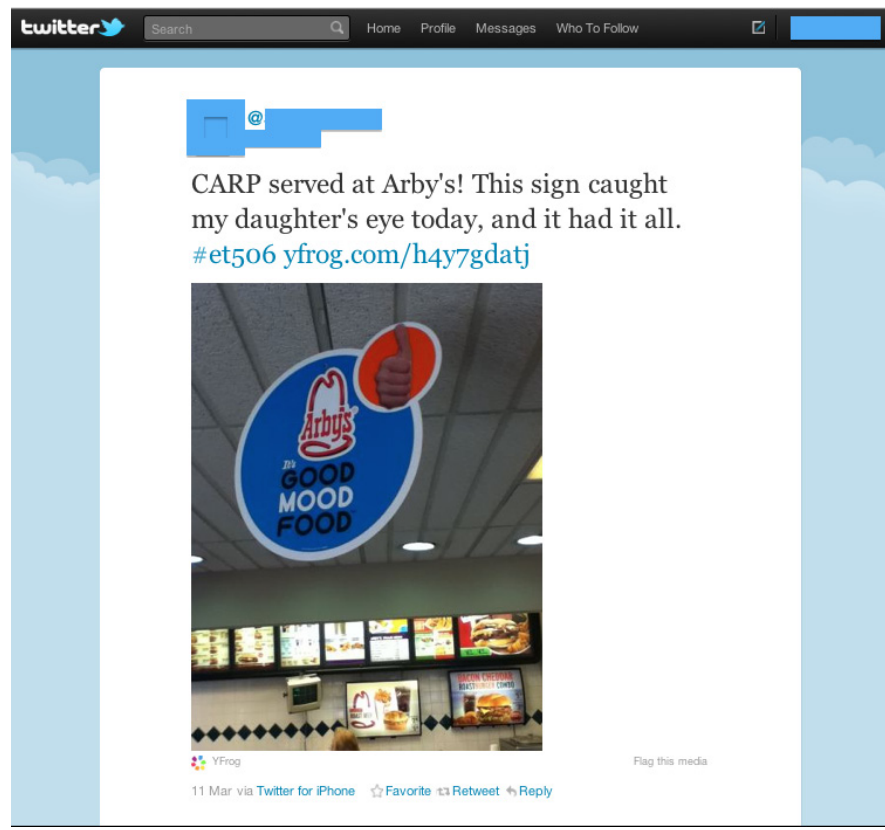
Figure 2. A tweet with a design example and concise comment on its context and design